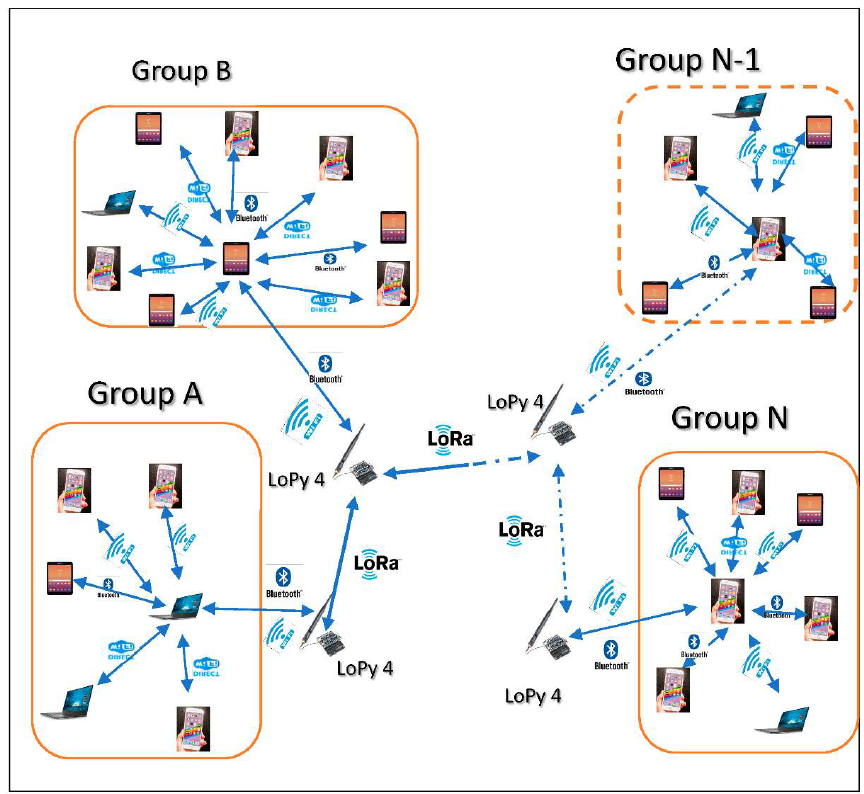
Figure 3. Groups of objects (devices) that communicate using Pycom’s LoPy4.